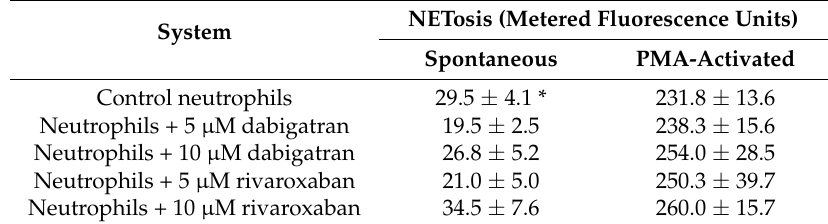
Table 2. Effects of dabigatran and rivaroxaban on spontaneous and PMA-activated